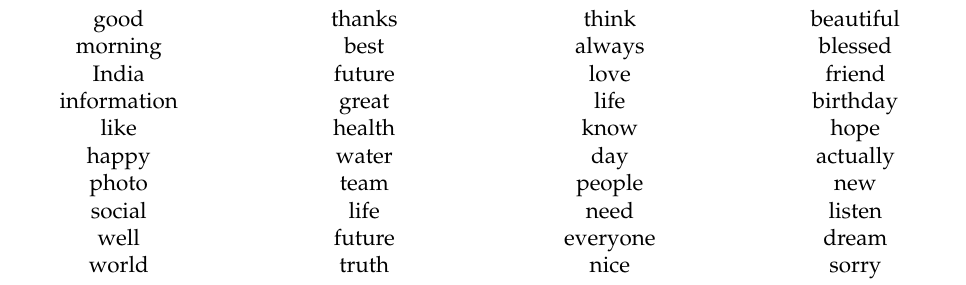
Table 6. Most frequent words using NMF and